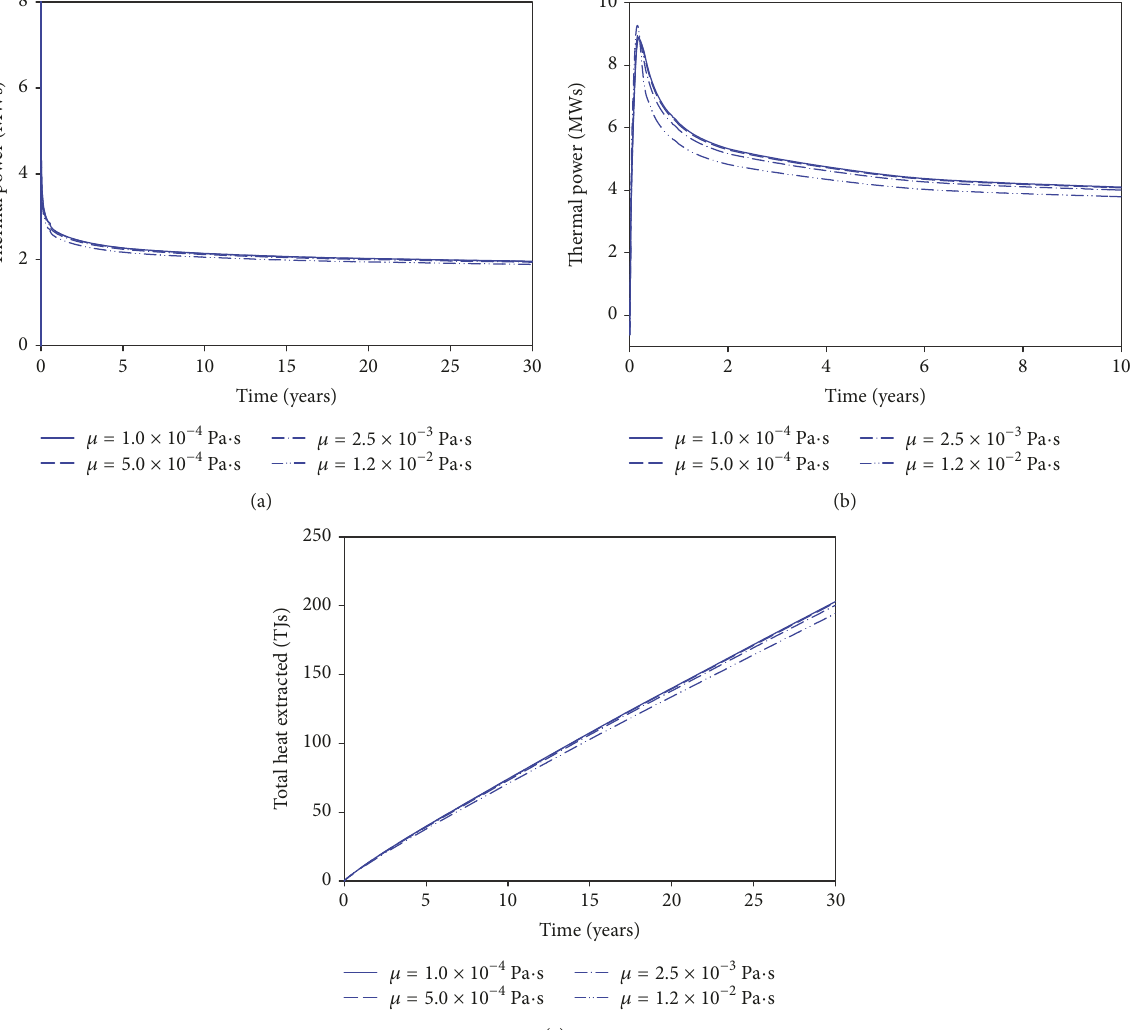
Figure 9: Variation with time of output temperature of the production well under different viscosities 𝜇 : (a) for large time period and (b) for short time period.